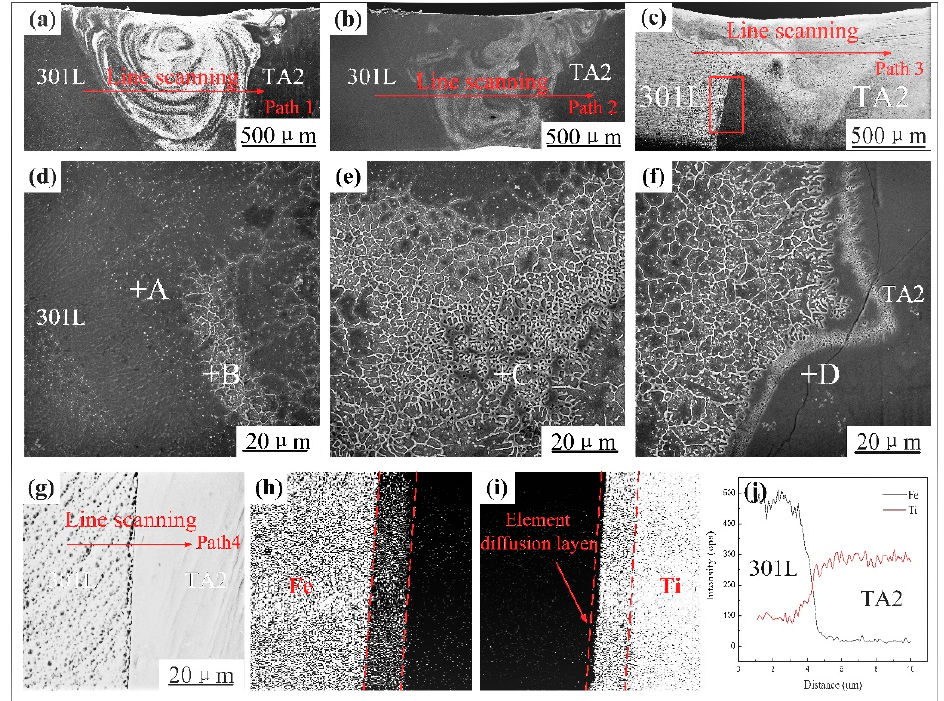
Figure 3. The cross-sectional morphologies and microstructures of 301L/TA2 welded joints: ( a – c ) Morphologies with laser offsets of − 0.3 mm, 0 mm, +3 mm, respectively; ( d – f ) microstructures with laser offsets of 0 mm on 301L side, welding center, TA2 side, respectively; ( g ) the enlarged view of red box region in Figure 3c and the path of line scanning; ( h , i ) the map scanning results of Figure 3g; ( j ) the line scanning results of Figure 3g.